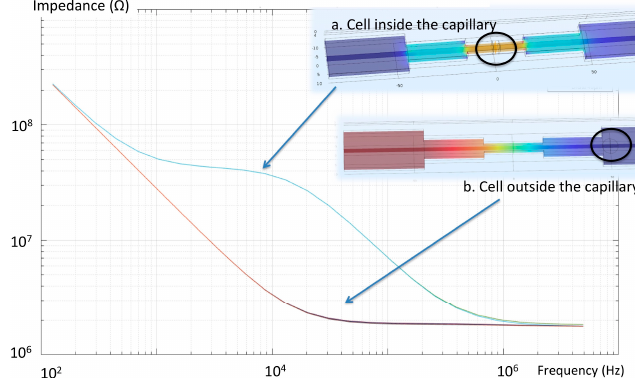
Figure 2. Simulated bioimpedance evolution with frequency in relation with RBC